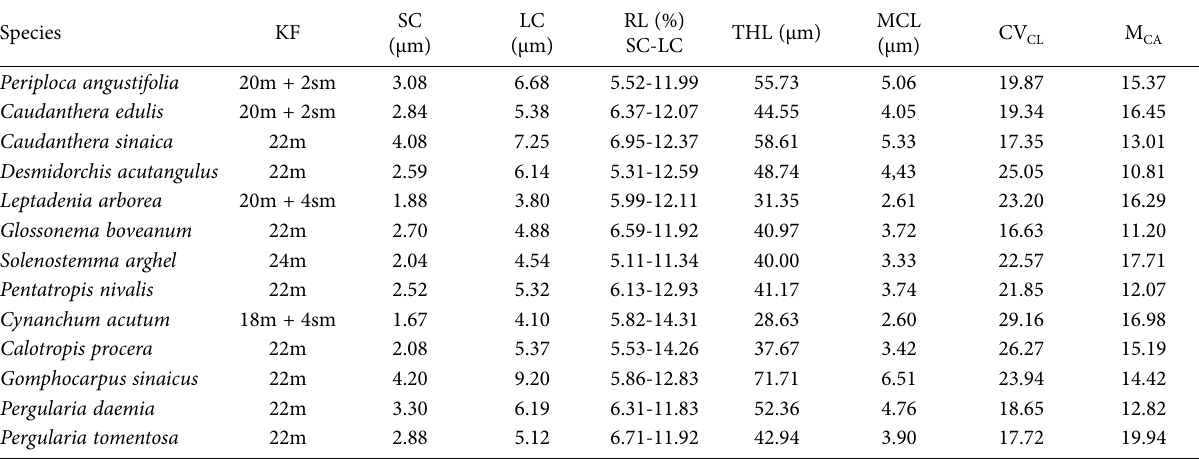
Table 3. The measurement data of the studied Apocynaceae species.